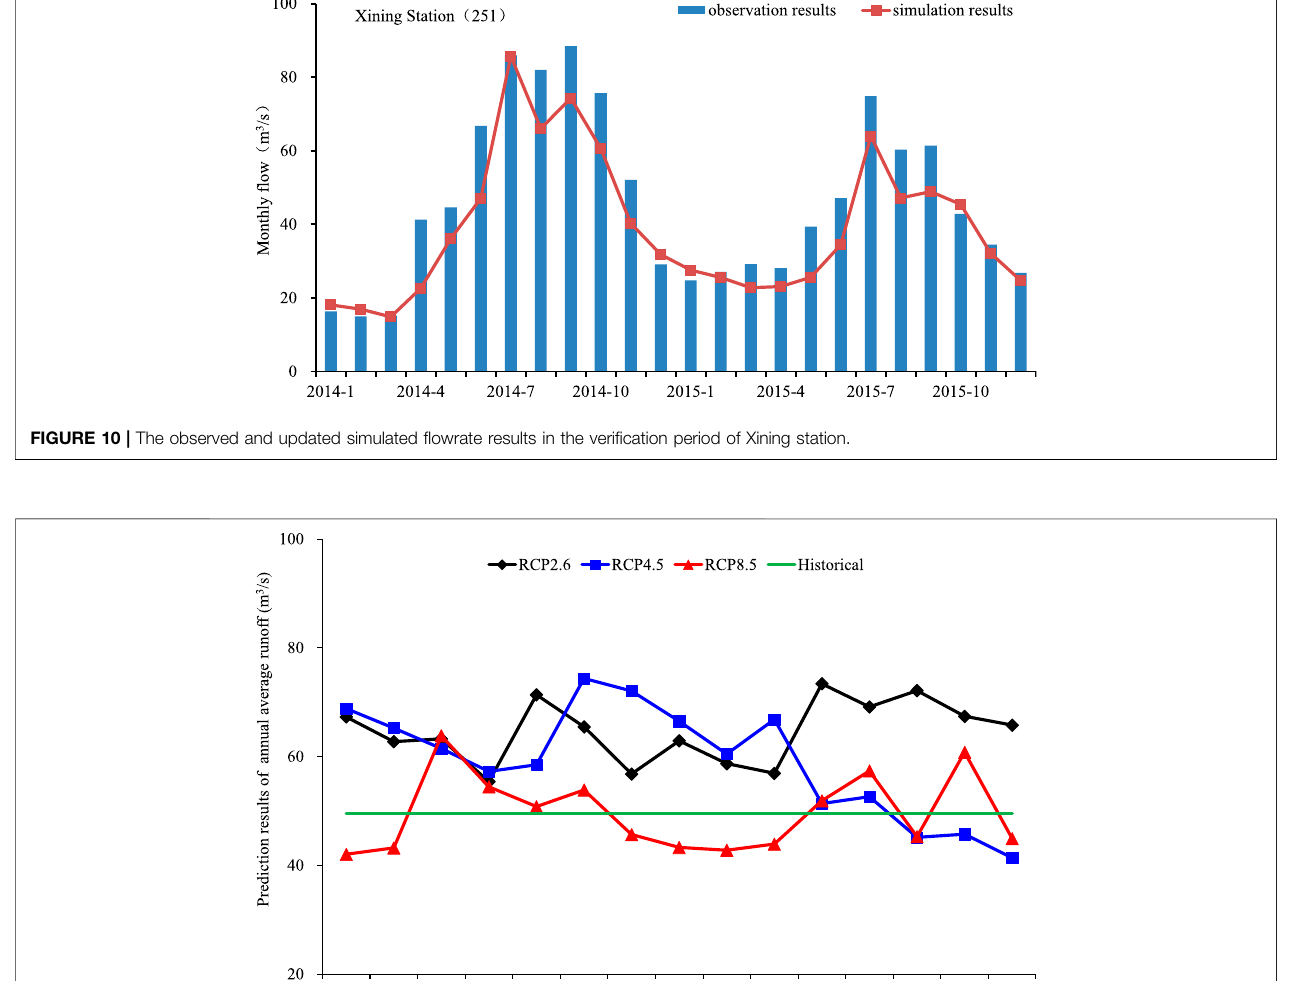
Frontiers in Earth Science |